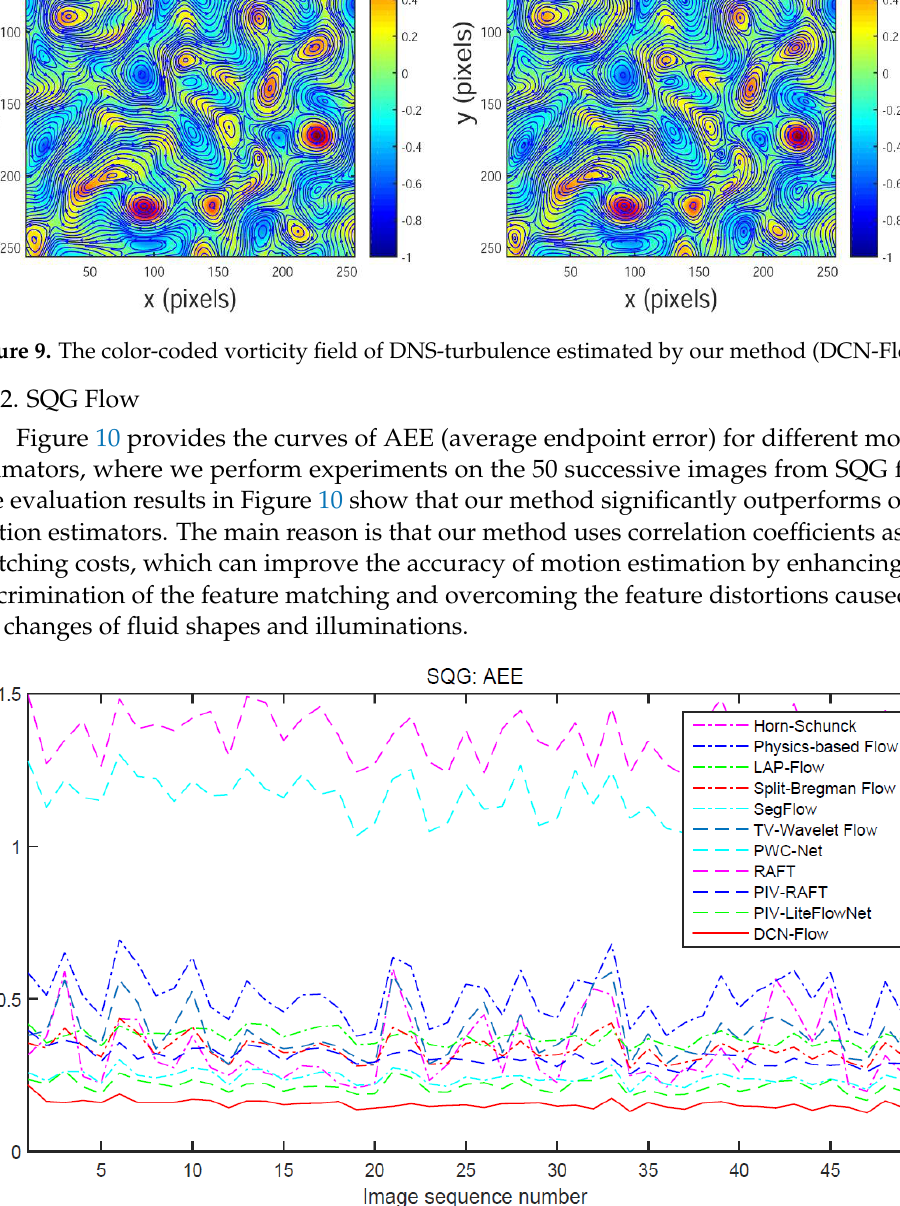
Figure 10. The curves of AEE (average endpoint error) for different motion estimators (Horn – Schunck [8], Physics-based Flow [38], LAP-Flow [40], Split-Bregman Flow [41], SegFlow [42], TV-Wavelet Flow [39], PWC-Net [23], RAFT [11], PIV-RAFT [11], PIV-LiteFlowNet [10], DCN-Flow) on the 50 successive images from SQG flow.